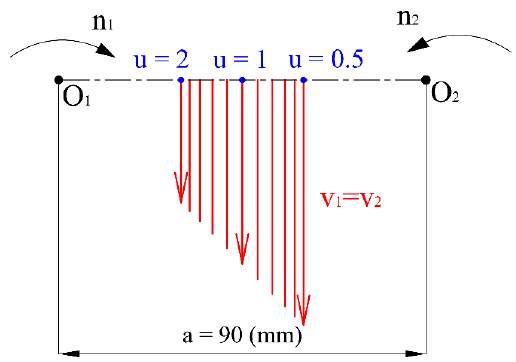
Figure 27. Change of the magnitude and the position of the circumferential velocity in central points of mesh of teeth pairs.